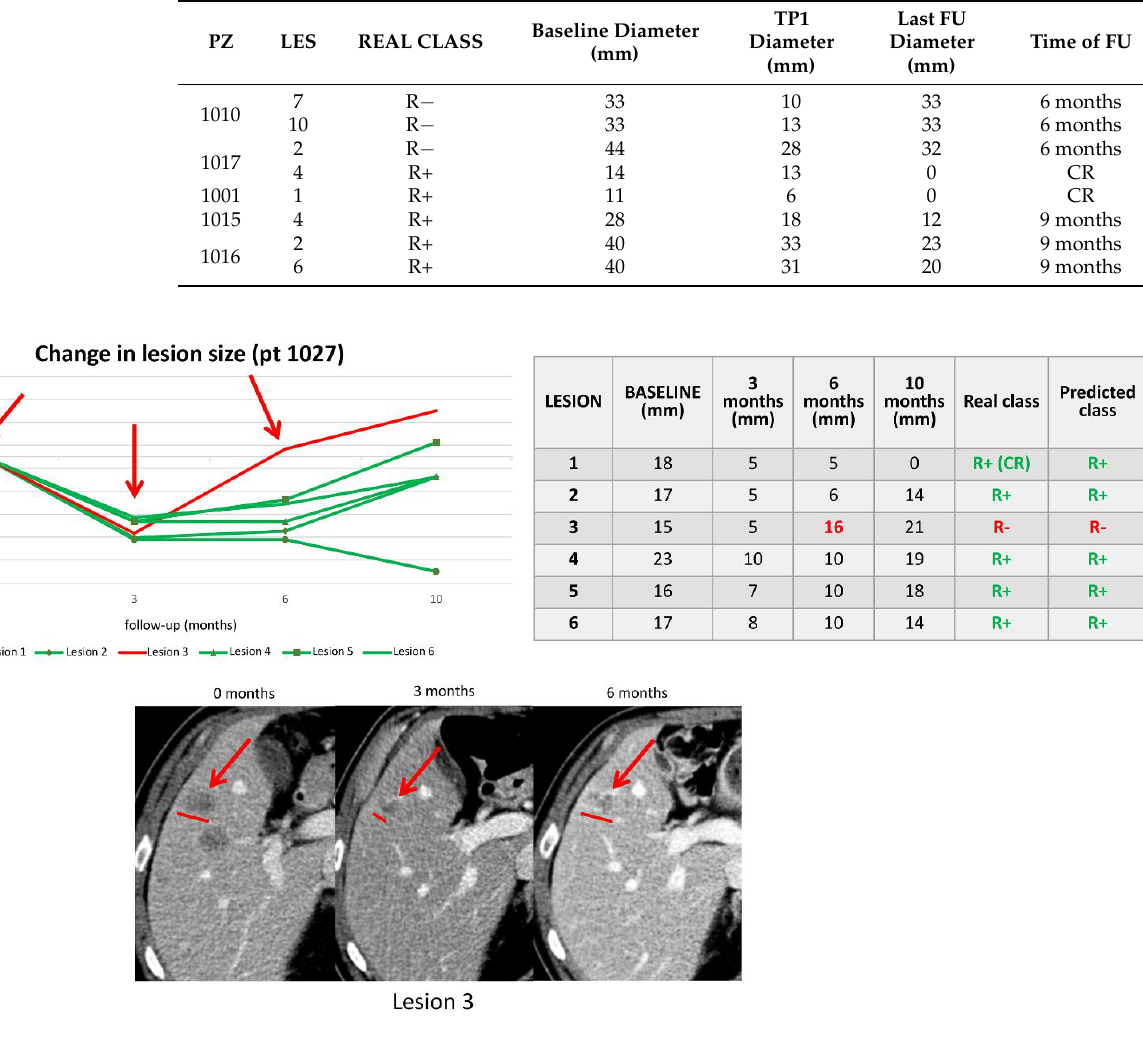
Figure 3. In patient 1027, our algorithm correctly classified a R+ 5 liver metastases that responded to therapy for 10 months and classified a R − 1 liver lesion (i.e., lesion 3) that showed a PD after 6 months of treatment. The red line in the graph represents the metastasis that went in progression before 8 months, while green lines represent metastases that respond for at least 8 months. The table lists the patient’s liver metastases, size at baseline, and subsequent timepoints. The real and predicted class columns show the 8-month response of each lesion based on size variations and the classification as predicted by the classifiers.